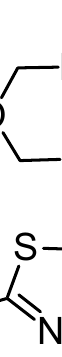
Figure 1. Chemical structure of Thiamethoxam.